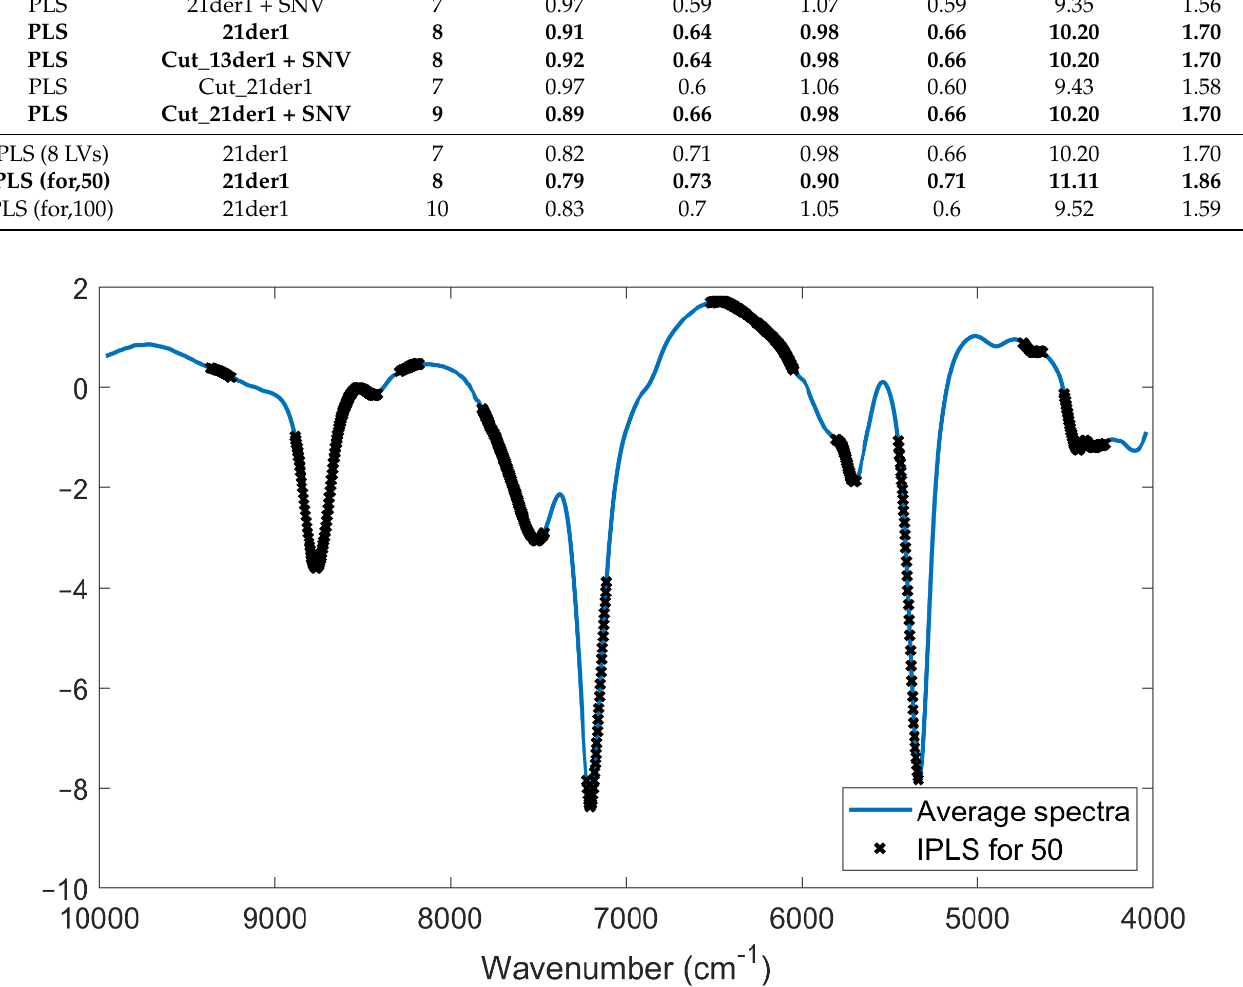
Figure 7. The average spectrum of the merged DB-2020 and DB-2021 datasets pretreated using first derivative (Savitzky–Golay filter, 21 smoothing points, second polynomial order) on the full spectral range. The variables selected by forward iPLS (50 intervals) are marked with black crosses. The red areas mark the most important wavenumber range for the prediction of SSC content (°Brix).